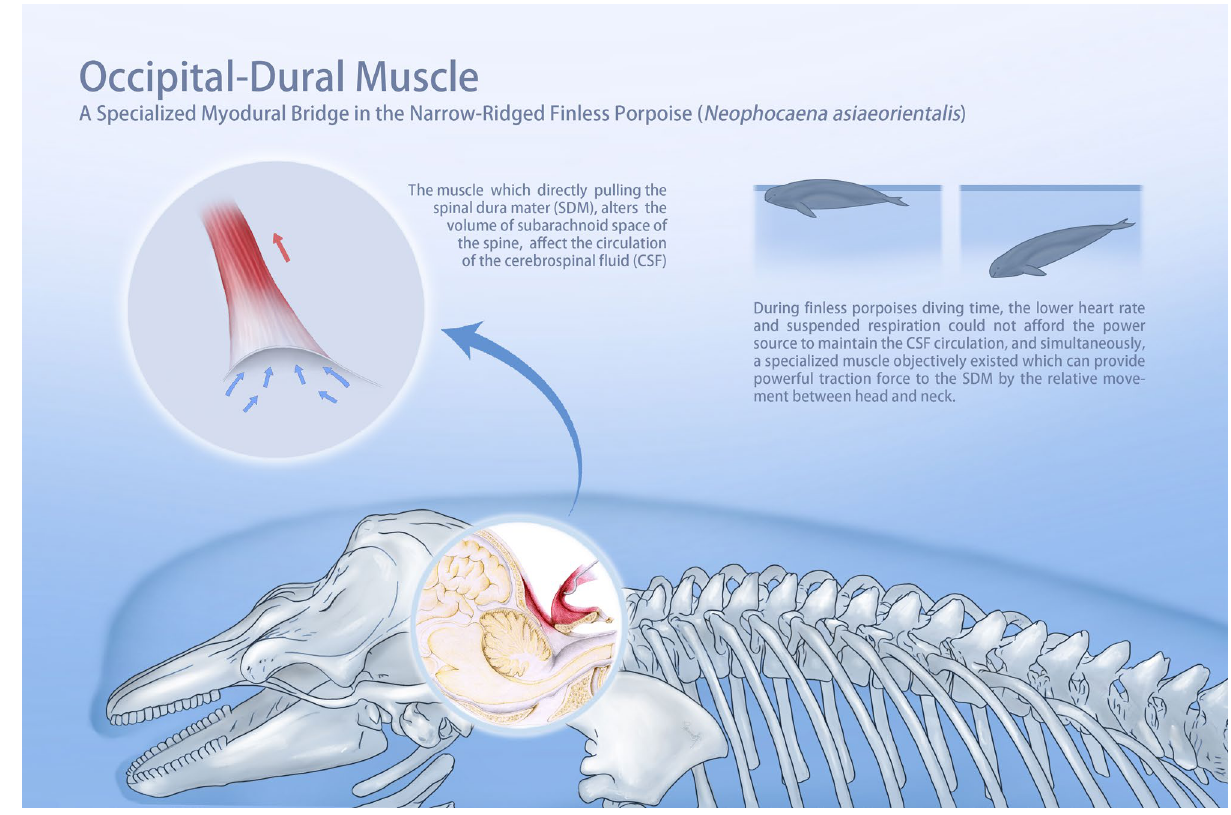
Figure 7. Image demonstrates the occipital-dural muscle pulling on the spinal dura mater (SDM), which alters the volume of fluid within the subarachnoid space, thus affecting the circulation of the cerebrospinal fluid